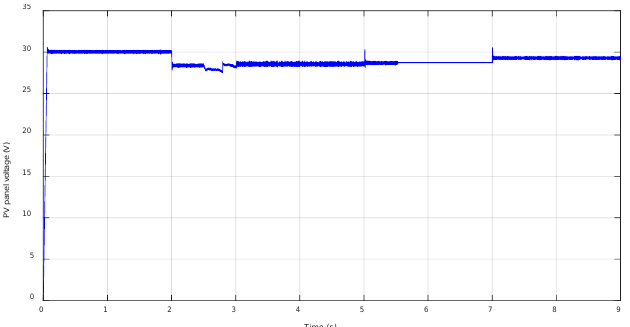
Figure 10. PV panel power.